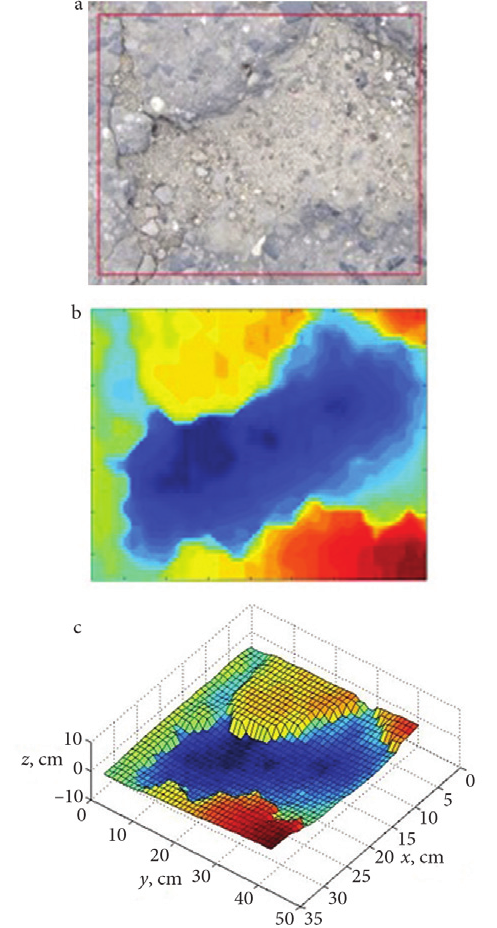
Fig. 4. Representation of the road surface: a – example image of road distress; b – depth map of road distress; c – spatial representation of mapped road